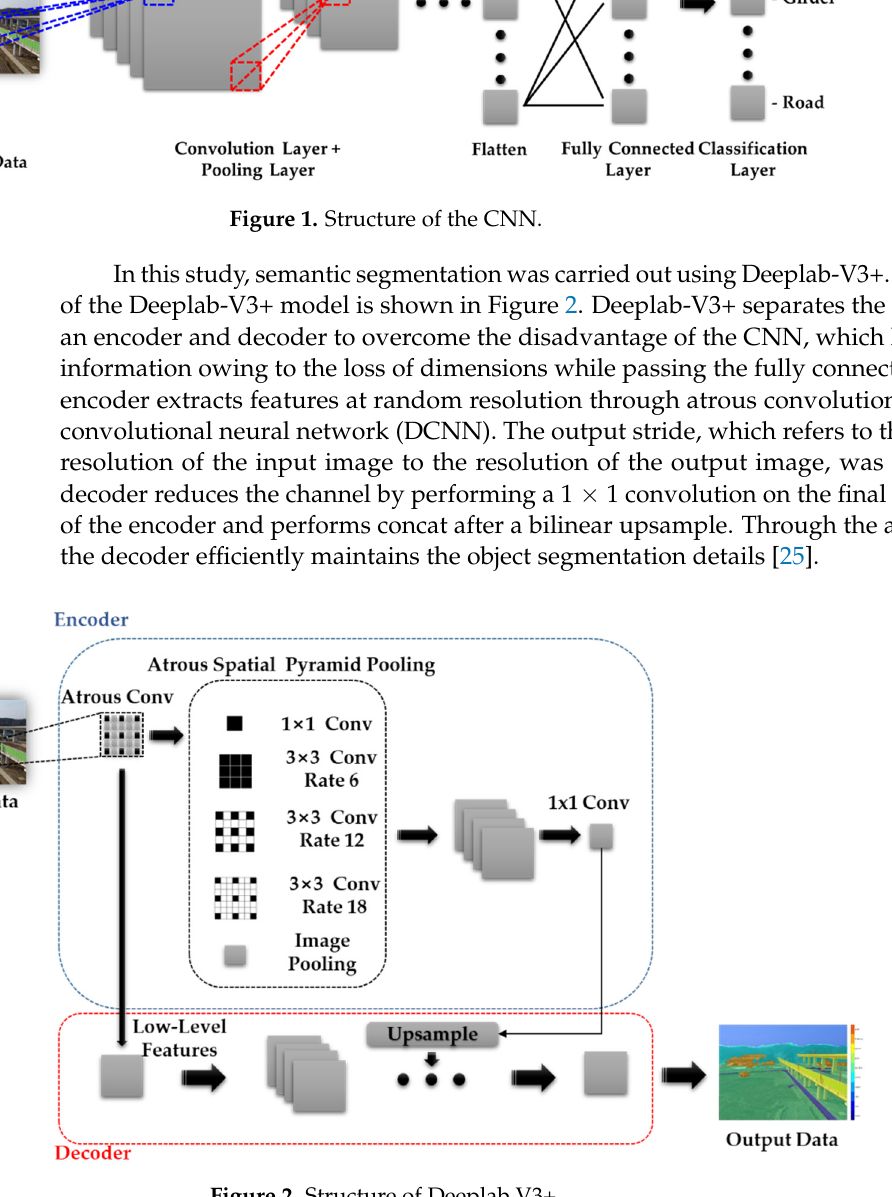
Figure 2. Structure of Deeplab V3+.